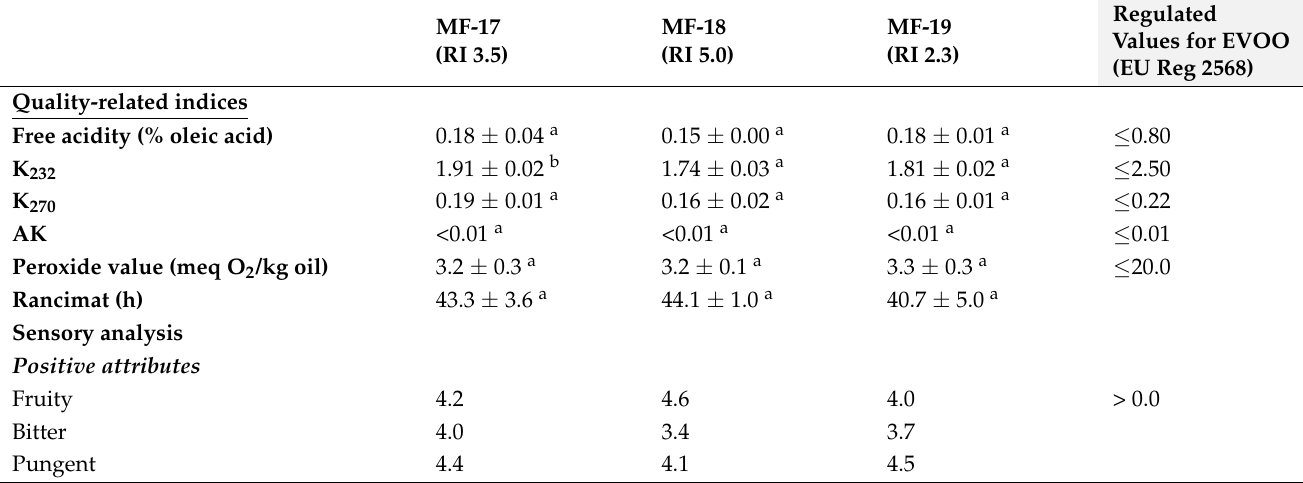
Table 1. Quality-related indices, sensory attributes, and composition of the studied olive